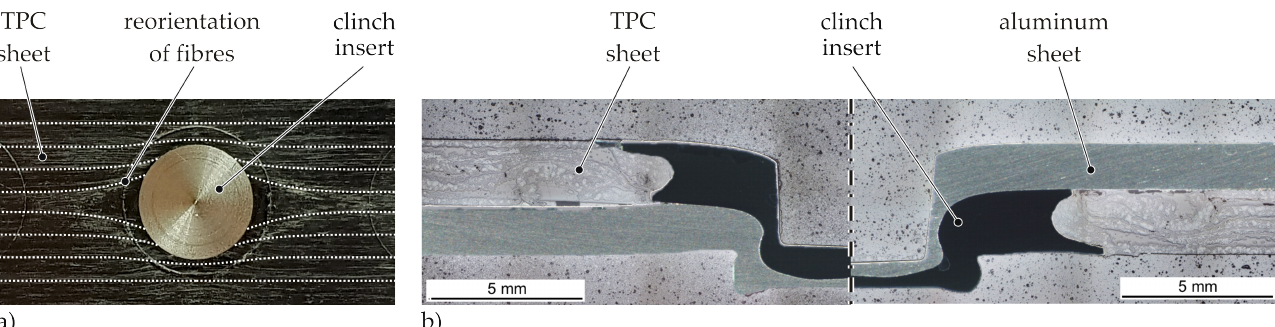
Figure 12. ( a ) Photograph of a TPC specimen with embedded clinch insert V1, ( b ) micrographs of clinch joints with punch- and die-sided clinch insert